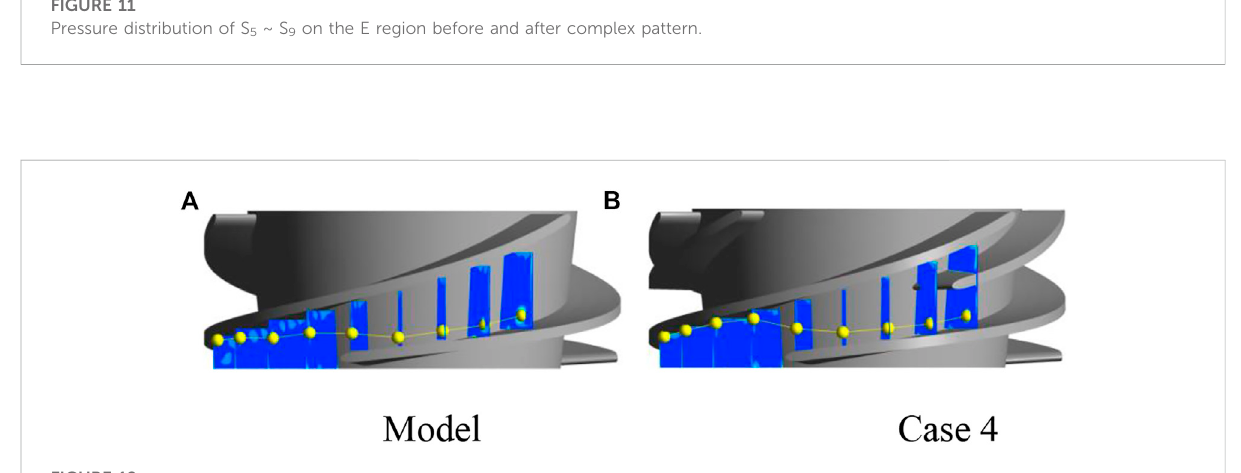
FIGURE 12 Trajectory of gas mass aggregation. (A) Model. (B) Case